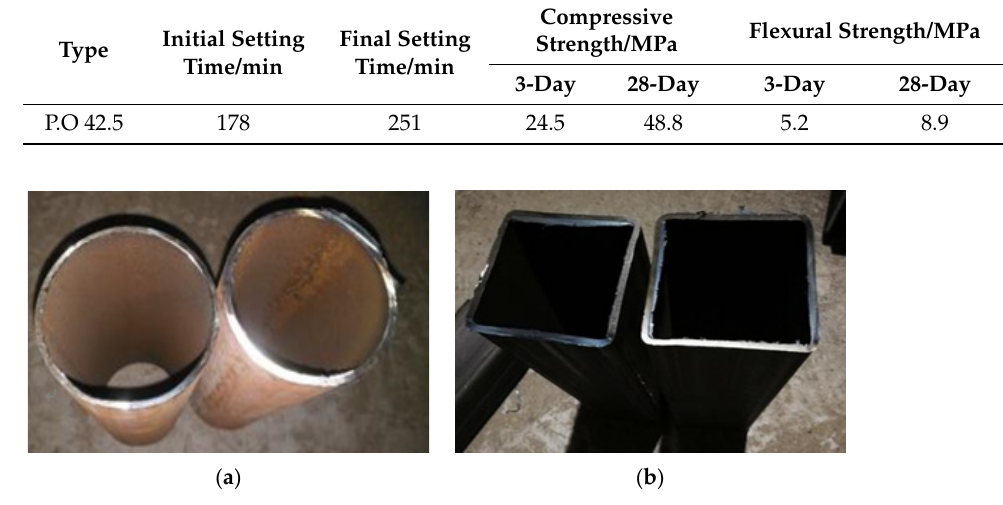
Figure 1. Steel tube: ( a ) Round steel tube; ( b ) Square steel tube. Table 1. Performance of cement. Table 2. Mix proportions of concrete (kg m − 3